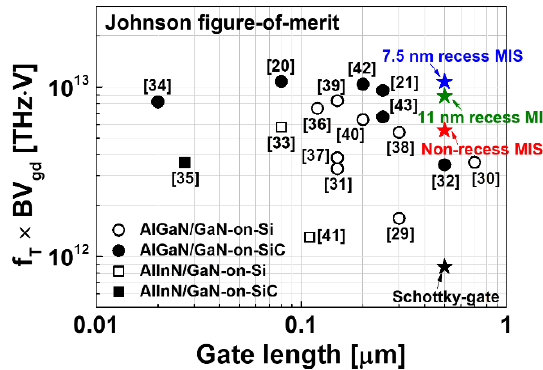
Figure 10. J-FOM as a function of gate length reported for GaN-based HEMTs.